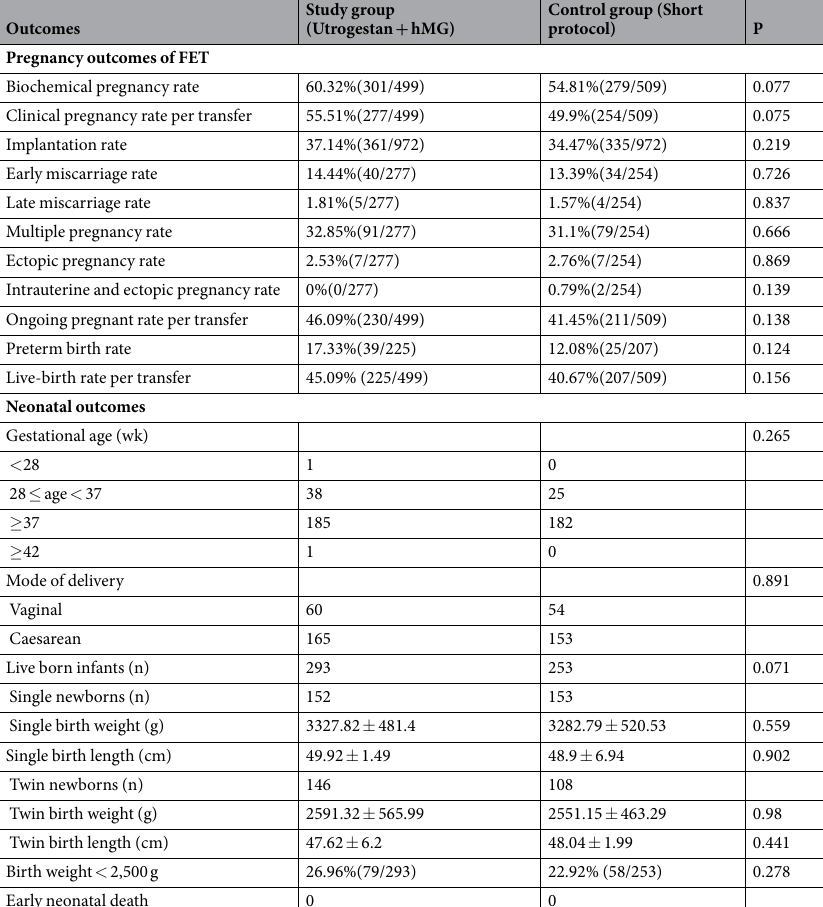
Table 2. Pregnancy and neonatal outcomes stratified by ovarian stimulation method.